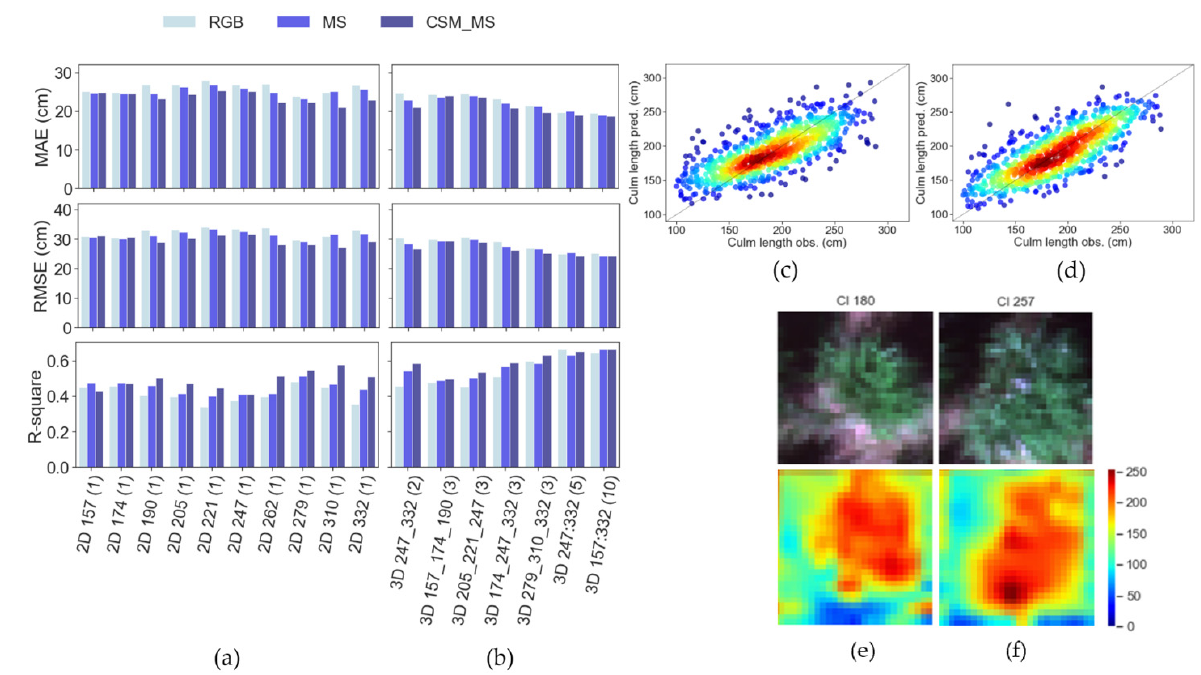
Figure 5. Evaluation of culm length prediction in testing data for ( a ) 2D models by DAP and ( b ) 3D models by number of time-frame sequences via the MAE, RMSE, and R 2 metrics. Observed and predicted values for the best ( c ) 2D models and ( d ) 3D models for testing datasets with low- (blue) to high-density (red) sample distribution. Example RGB image chips and activation maps for ( e ) low and ( f ) high-culm-length plants from the 2D-based model of aerial data collected on DOY 279. The level of activation of the deepest CNN layers in the images is represented by low (blue), intermediate (yellow), and high (red) values on a 0–255 scale.